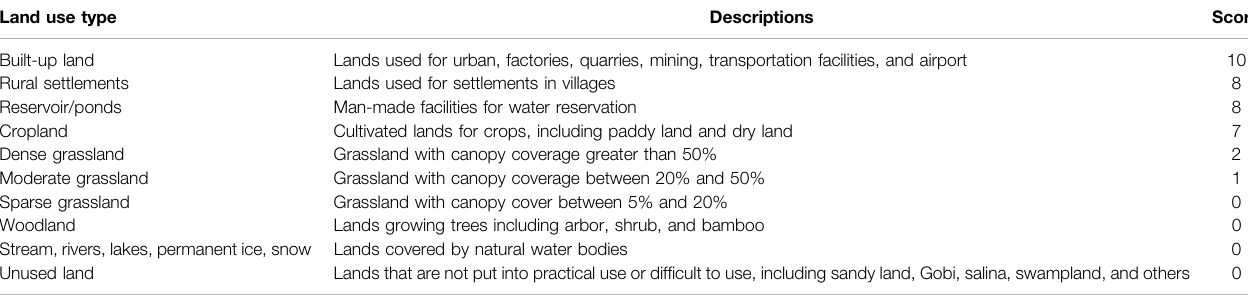
TABLE 1 | Land use types and their human in fl uence scores (Li et al., 2018).